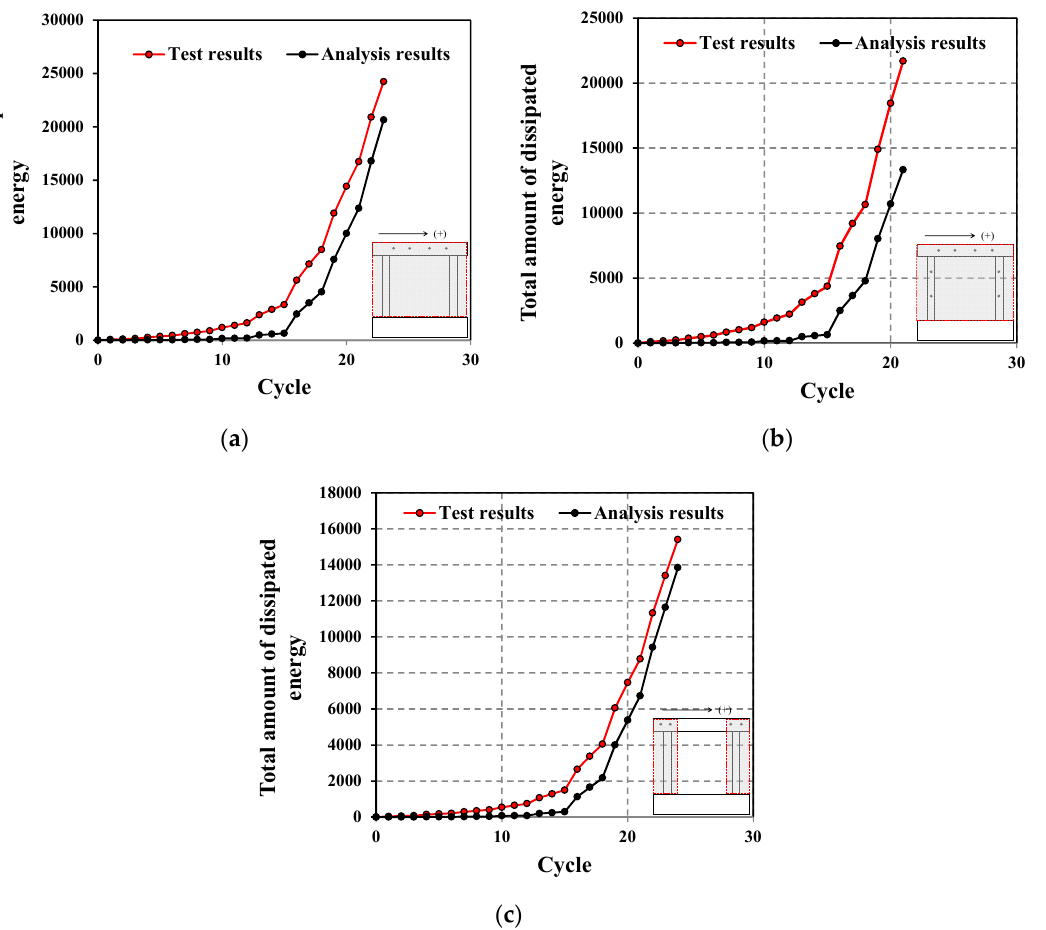
Figure 15. Measured and estimated cumulative energy dissipation: ( a ) Specimen FB; ( b ) Specimen FBC; ( c ) Specimen